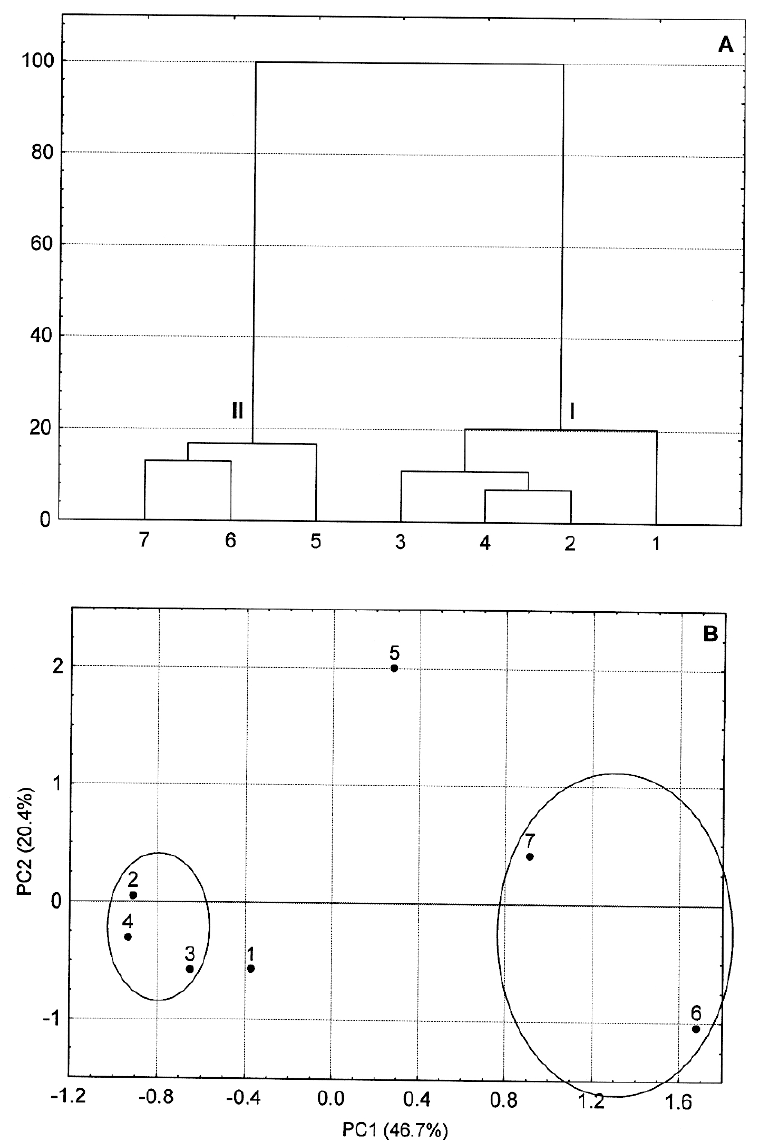
Figure 9. CA dendrogram (A) and PCA score plot (B) for physical mixtures and inclusion complexes of salicylamide with β -cyclodextrin: 1 (PM), 2 (PR), 3 (PE) and 4 (KN), and with 2-hydroxypropyl- β -cyclodextrin: 5 (PM), 6 (PE) and 7 (KN). The graphs are calculated from the thermoanalytical and spectral data compiled in Tables